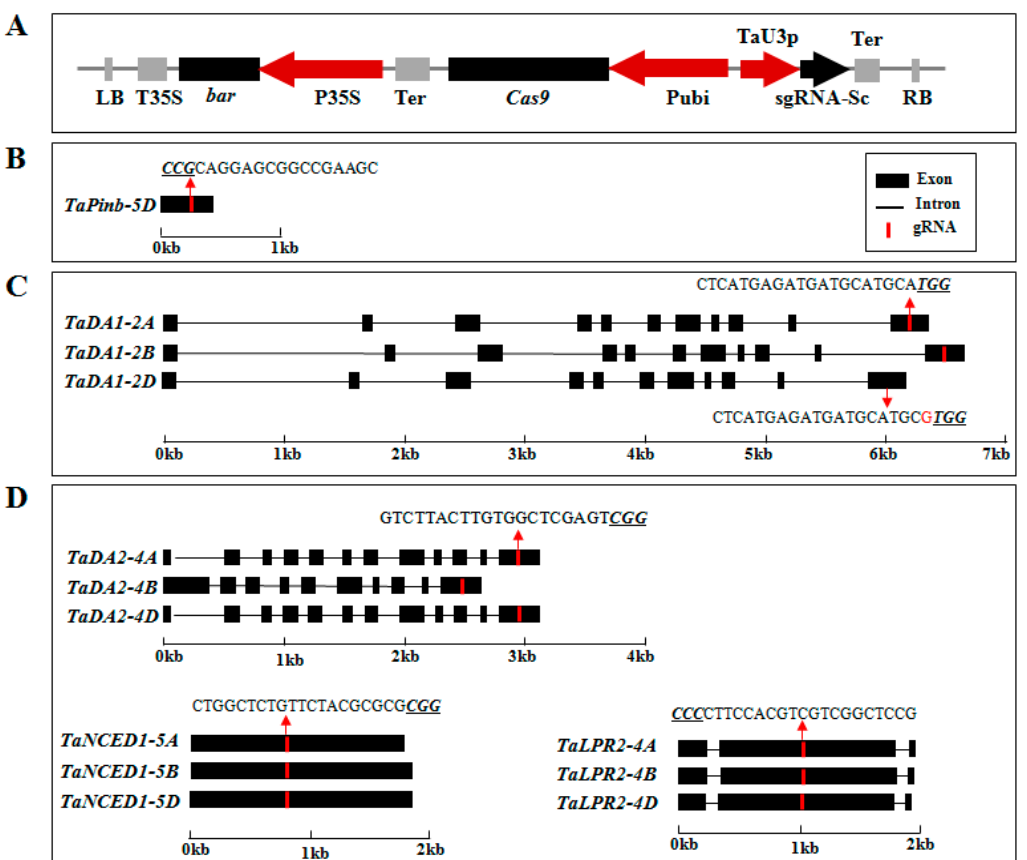
Figure 1. Schematic map of the binary vector and sgRNA selection in the target genes used for wheat transformation. ( A ) The T-DNA region of the binary vector used for genome editing in wheat. Cas9 was expressed with a ubiquitin promoter, and the sgRNA was derived using U3 promoters. ( B ) The gene structure of TaPinb and its sgRNA targeting the 5D genome. The TaPinb gene is a single-copy gene. ( C ) The gene structure of TaDA1 and the design of its sgRNA targeting A and B homologues. The sgRNA of the TaDA1 gene was designed to target the conserved sites of the A and B genomes but showed a mismatch to the D genome at position one at the 3 (cid:48) end. ( D ) The gene structure of TaDA2 , TaNCED1 and TaLPR2 and the design of their sgRNAs targeting all three homologues. Introns are shown as lines, and exons are shown as black boxes. Target sites are indicated in red. The protospacer adjacent motif (PAM—NGG) sites are underlined and indicated in